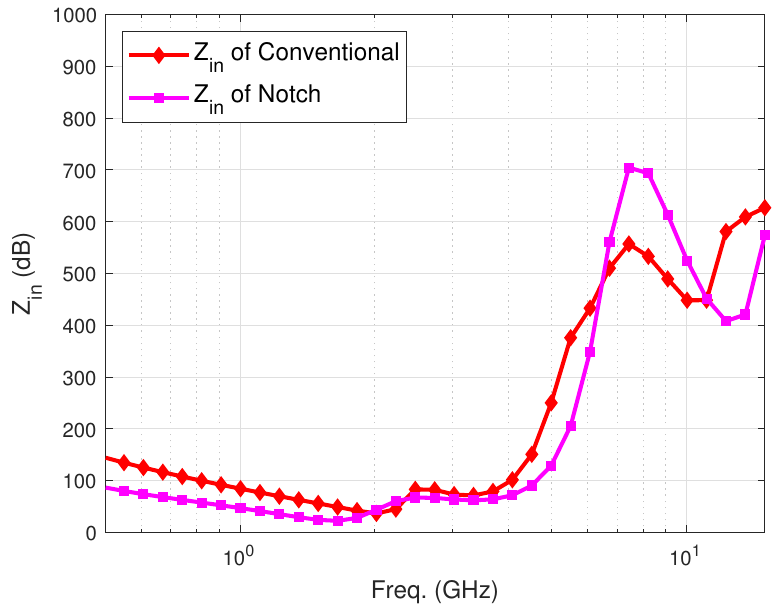
Figure 4. Input impedance (Z in ) of the proposed notch LNA compared to the conventional